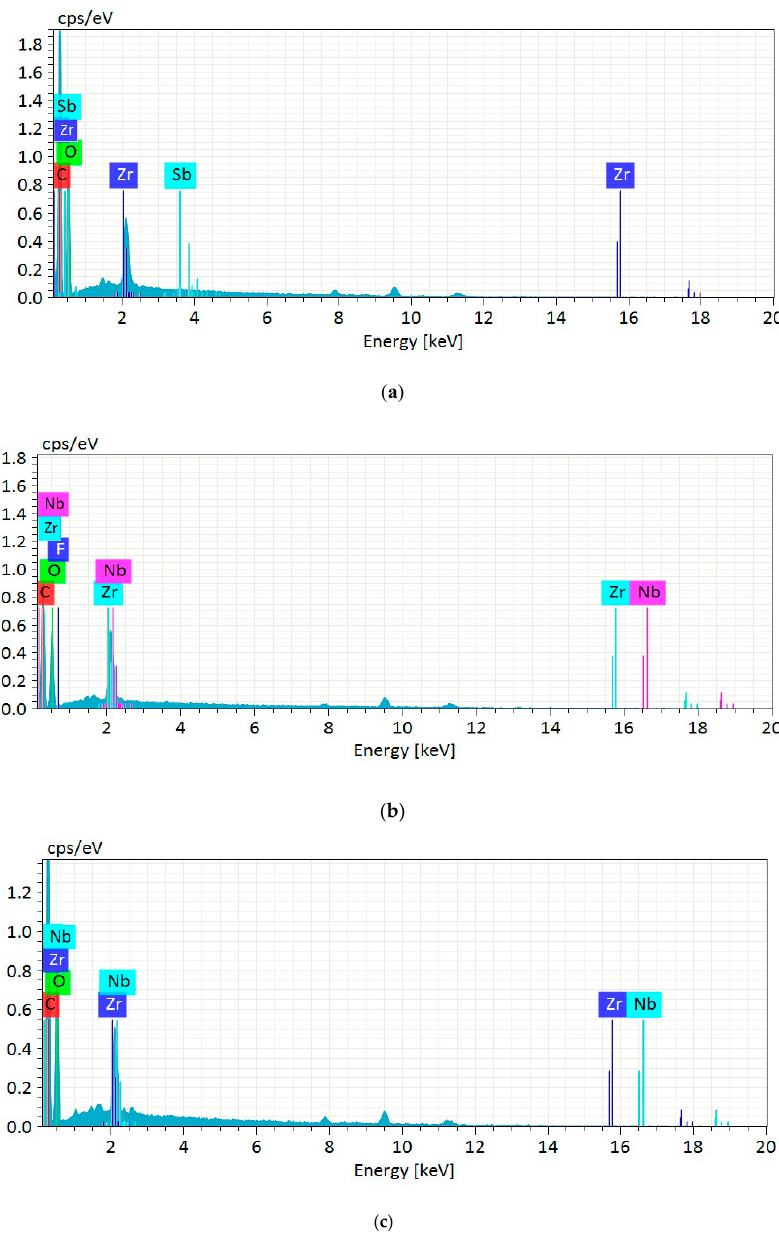
Figure 2. EDX spectra of ( a ) CPBLH, ( b ) CPAKL, and ( c ) CPMCC samples. Table 1. Elements composition and yield of fiber samples.